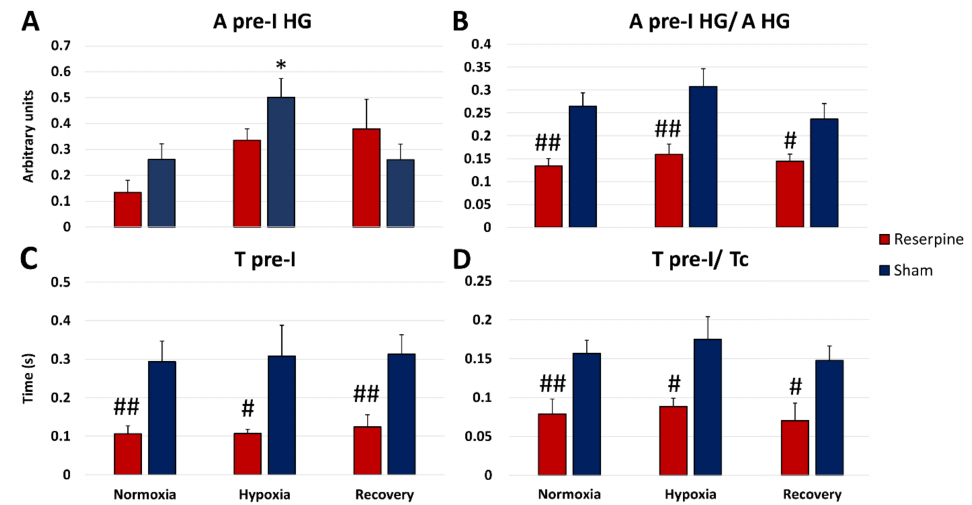
Figure 5. The average pre-inspiratory hypoglossal nerve amplitude (A pre-I HG) ( A ), a ratio of the pre-inspiratory hypoglossal nerve amplitude to the inspiratory HG peak amplitude (A pre-I HG/A HG) ( B ), pre-inspiratory time of HG (T pre-I) ( C ) and the ratio of pre-inspiratory time of HG to a total length of the respiratory cycle (T pre-I/Tc) ( D ) in respiratory response to hypoxia in rats injected i.p. with vehicle (sham) or reserpine. All values are given as mean ± SEM. All values are given as mean ± SEM. *# P < 0.05; ## P < 0.01, *—statistical significance in comparison to normoxic value, #—statistical significance between corresponding values in reserpine and sham groups ( n = 7–9 per group).